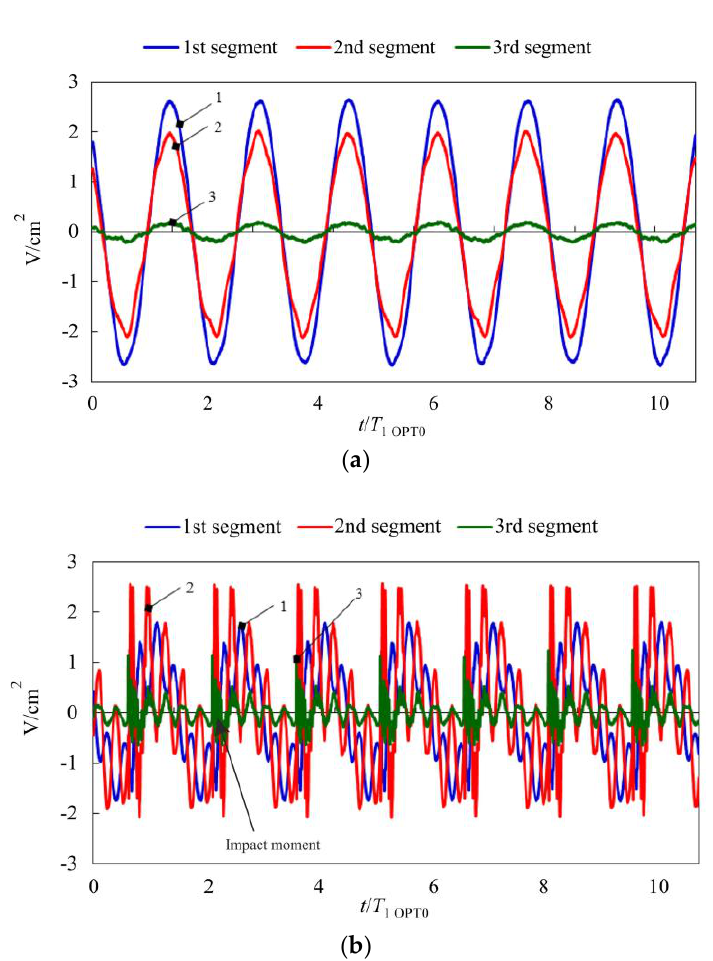
Figure 16. Measured open-circuit voltages for the VEH prototype OPT RAT operating in ( a ) freely vibrating mode; ( b ) vibro-impacting mode with a stopper at x/l = 1 (1st piezocomposite segment (near the clamped part of the microcantilever)—blue line (1), 2nd segment (in the middle)—red line (2), 3rd (at the free end)—green line (3)).